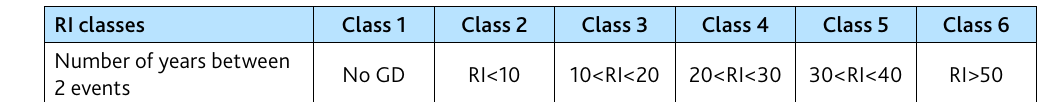
Table 1. Reccurence interval classes